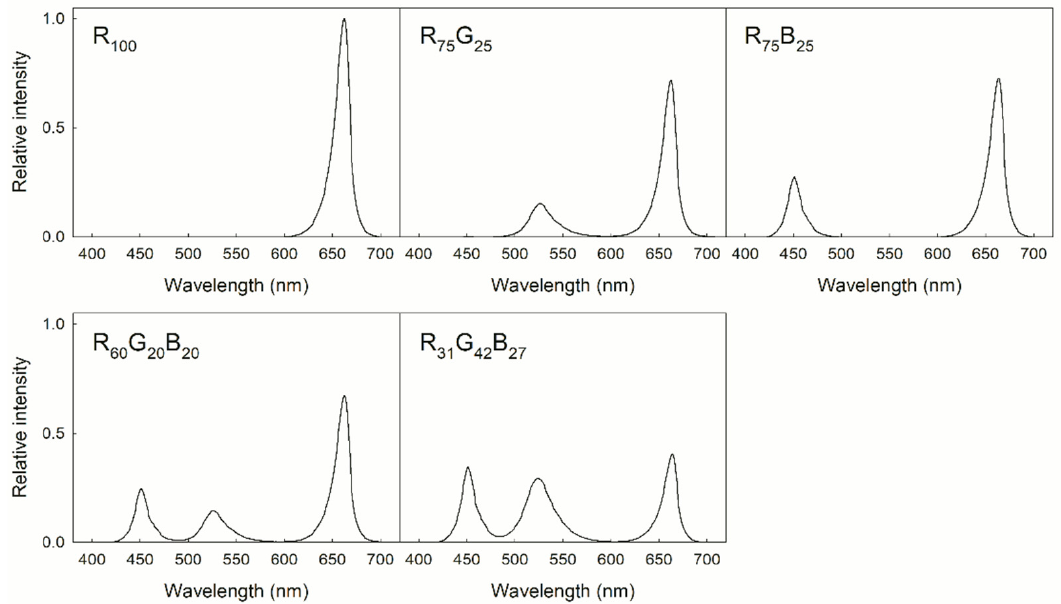
Figure 1. Spectral distributions of the five light quality treatments delivered by red [R (600–700 nm), peak = 664 nm], green [G (485–600 nm), peak = 524 nm], and blue [B (400–485 nm), peak = 451 nm] light-emitting diodes. The numbers after each waveband indicate the ratios of the intensities. The R 31 G 42 B 27 treatment mimics the sunlight spectrum measured in the experimental greenhouse.